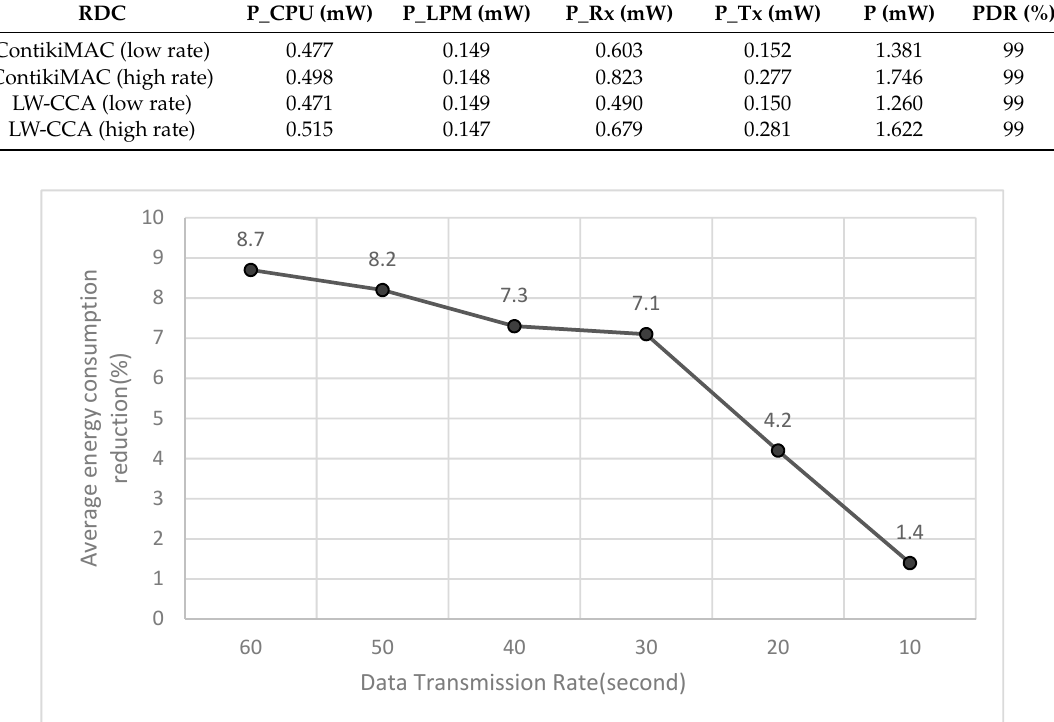
Figure 9. Average improvement of LW-CCA energy consumption at different data transmission rates.